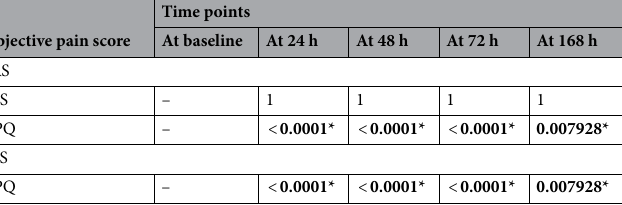
Subjective pain score